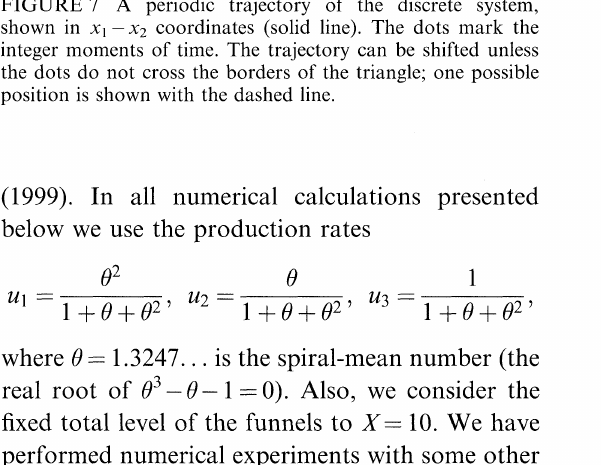
FIGURE 6 The period of the eventual periodic trajectory in dependence on initial point, shown in the initial coordinates (x,x2). The production rates are u =0.4, u2=0.4, u3=0.2. The total filling level is X= 3 in (a), X 2x/-J in (b) and X= 10 in (c). The color/grey codes for the periods are different on different panels. (See Color Plate I.)